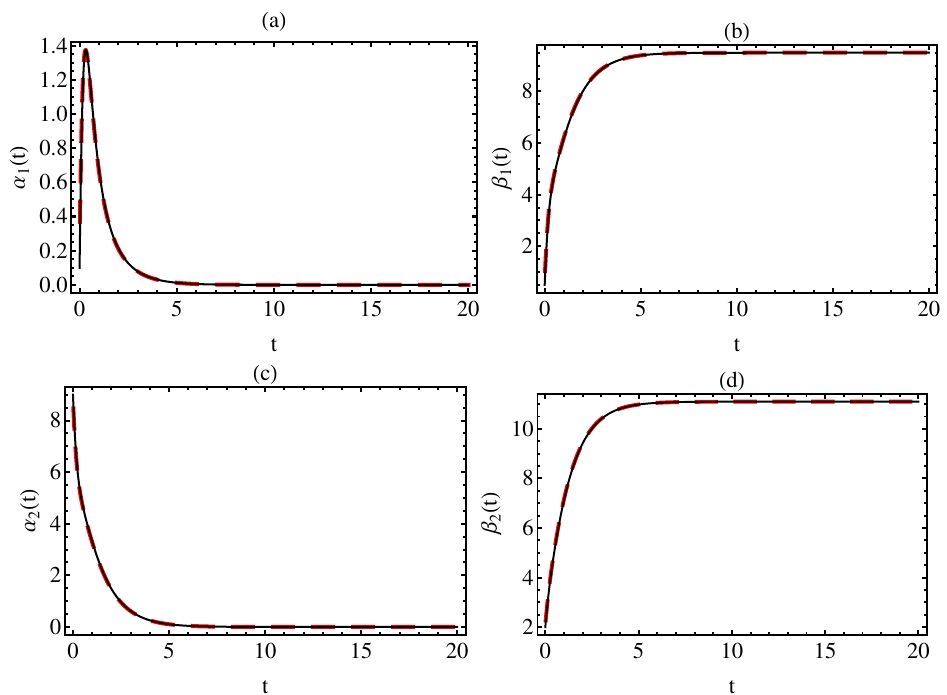
Figure 1. Comparison between the numerical solutions of Equations (36)–(39) via power-law kernel and numerical solution based on finite differences method for (cid:36) = 1, k = 1, δ = 1, γ = 2, σ = 1, and h = 0.01. Black solid line: numerical solutions of Equations (36)–(39); red dashed line: numerical solutions of Equations (12)–(15) using finite differences method. ( a ) α 1 ( t ) , ( b ) β 1 ( t ) , ( c ) α 2 ( t ) , and ( d ) β 2 ( t )